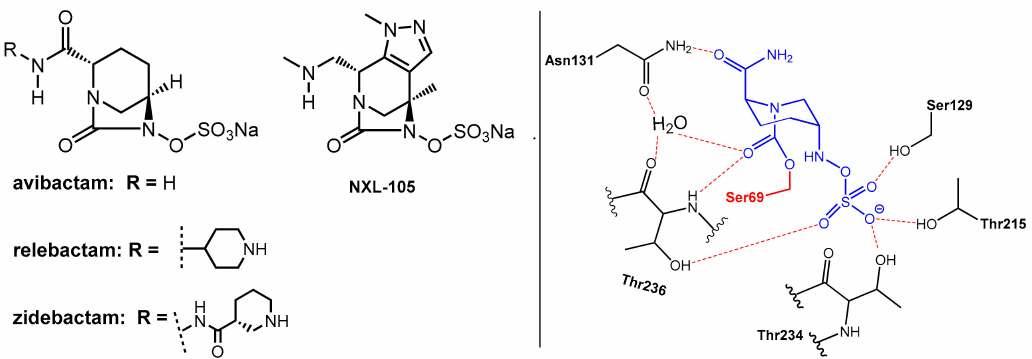
Figure 5. ( Left ): Structures of the 1,6-diazabicyclo [3.2.1] octane-type β -lactamase inhibitors avibactam, relebactam, zidebactam, and NXL-105. ( Right ) Reversible binding of avibactam (in blue) to the Ser69 (in red) residue of a β -lactamase from Klebsiella pneumoniae (from PDB ID: